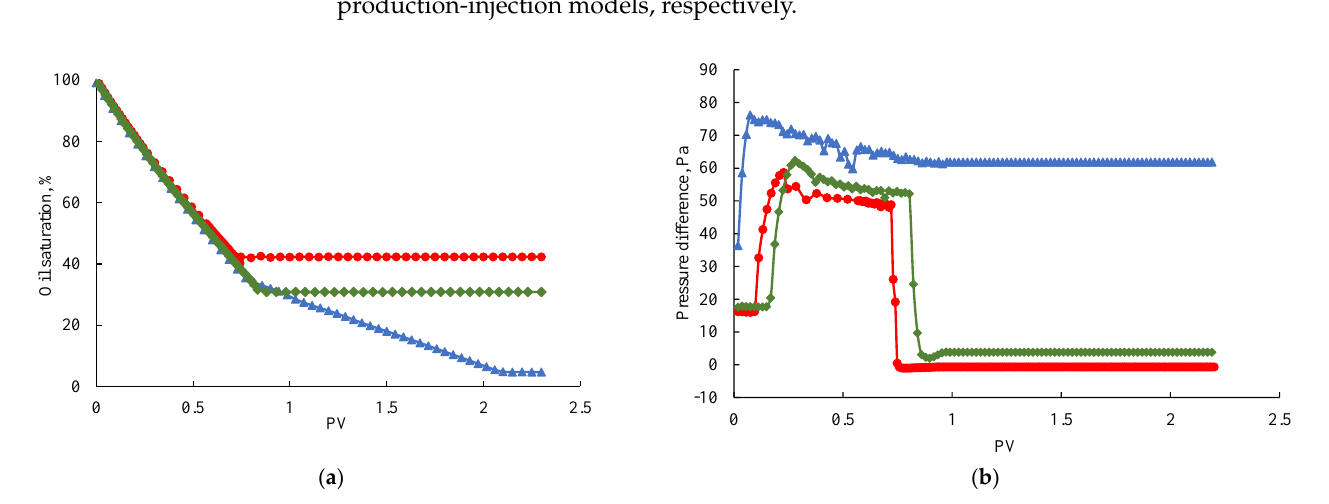
Figure 6. ( a ) Oil saturation and ( b ) pressure difference vs. PV for different injection method. (blue line: full perforation and commingling production micro-model; red line: partial perforation and com- mingling production-injection micro-model; green line: separated layer injection and commingling production